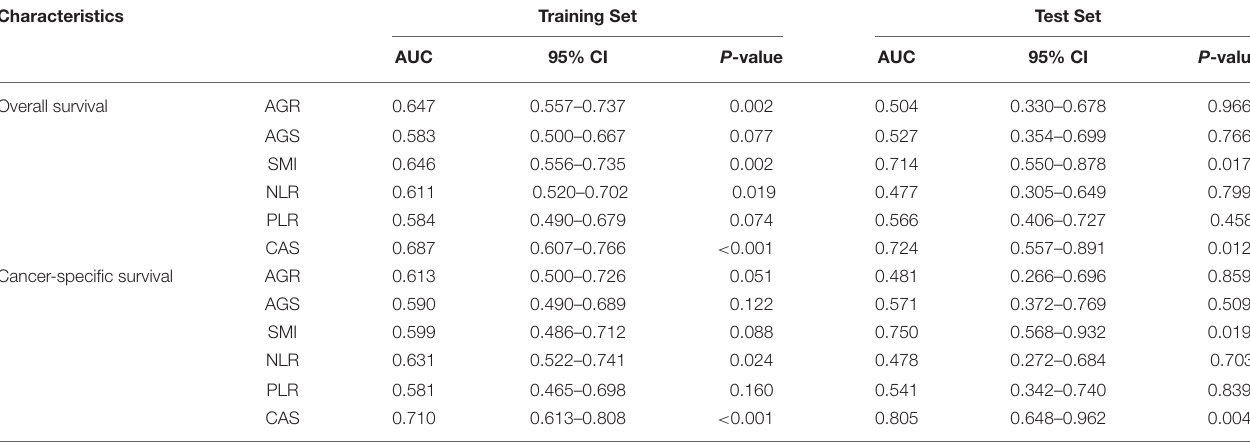
TABLE 5 | Accuracy of AGR, AGS, SMI and CAS in predicting overall survival (OS) and cancer-specific survival (CSS) by assessing the area under the curve (AUC) in the training and test sets. Characteristics